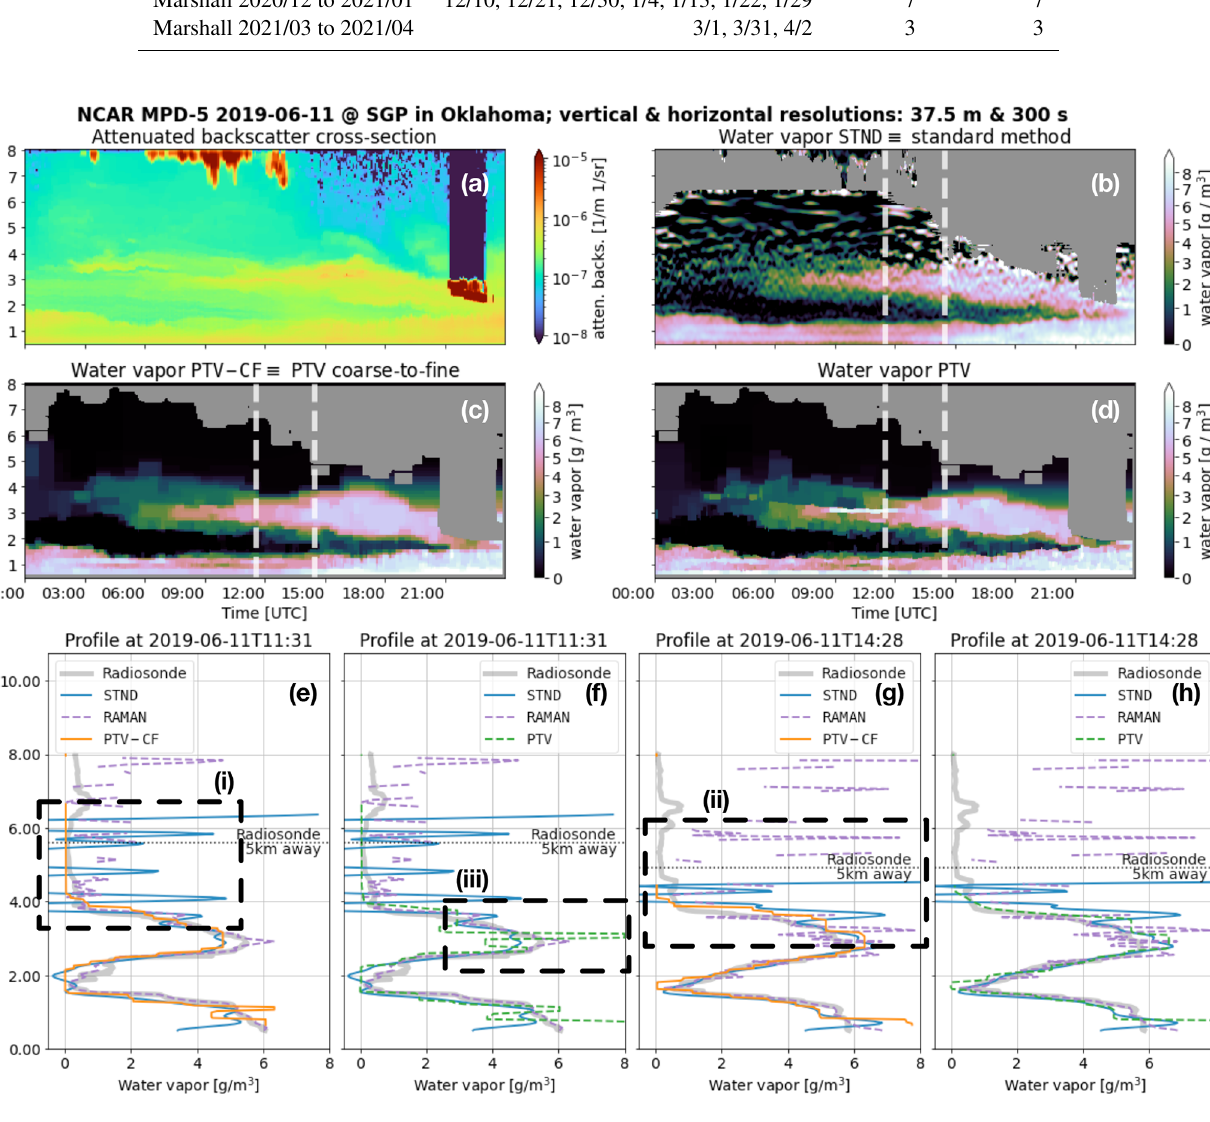
Figure 3. The (a) attenuated-backscatter cross section and the water vapor (WV) measurements of the (b) standard method ( STND ) and the PTV-MPD method (c) with ( PTV-CF ) and (d) without ( PTV ) the coarse-to-fine configuration. Panel (a) is not masked to show what atmospheric features have been masked out in (b) to (d) by the gray areas. The dashed white vertical lines in (b) to (d) show the launch times of the radiosondes (RSs), where (e) to (h) show the RS and Raman lidar WV profiles. Panels (e) and (g) compare the course-to-fine PTV-MPD WV measurements against those of the RS and the standard method, whereas (f) and (h) show the same comparison for the PTV-MPD method without the course-to-fine configuration. The horizontal dashed lines in (e) to (h) show the altitude at which the RS was horizontally 5km away from the MPD. The dashed boxes in (e) and (g) highlight regions that are discussed in the